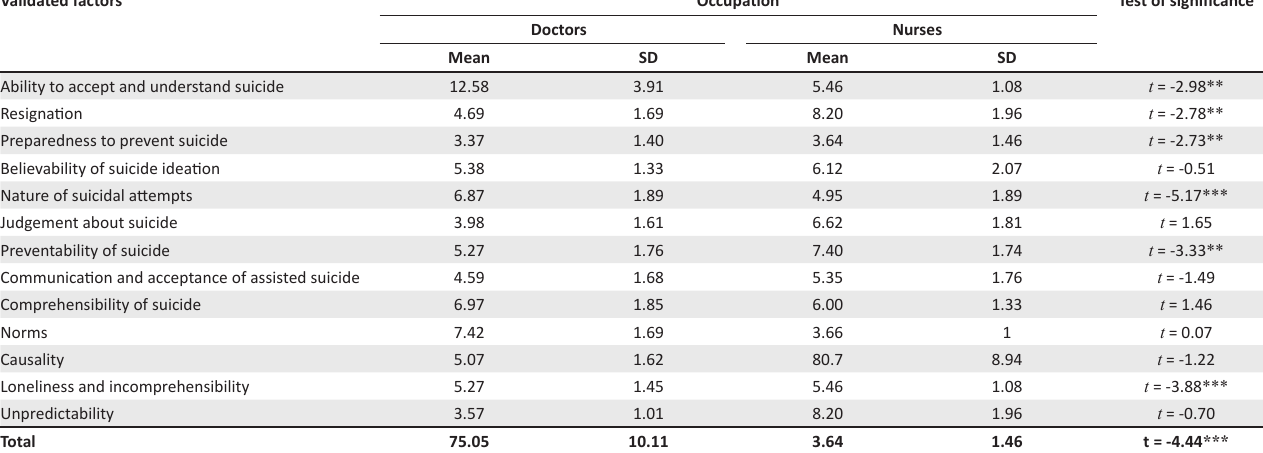
TABLE 3: Comparison of the validated 13-factor Attitudes Toward Suicide Scale scores among participants based on occupation (doctors and nurses). Validated factors Occupation Test of significance Doctors